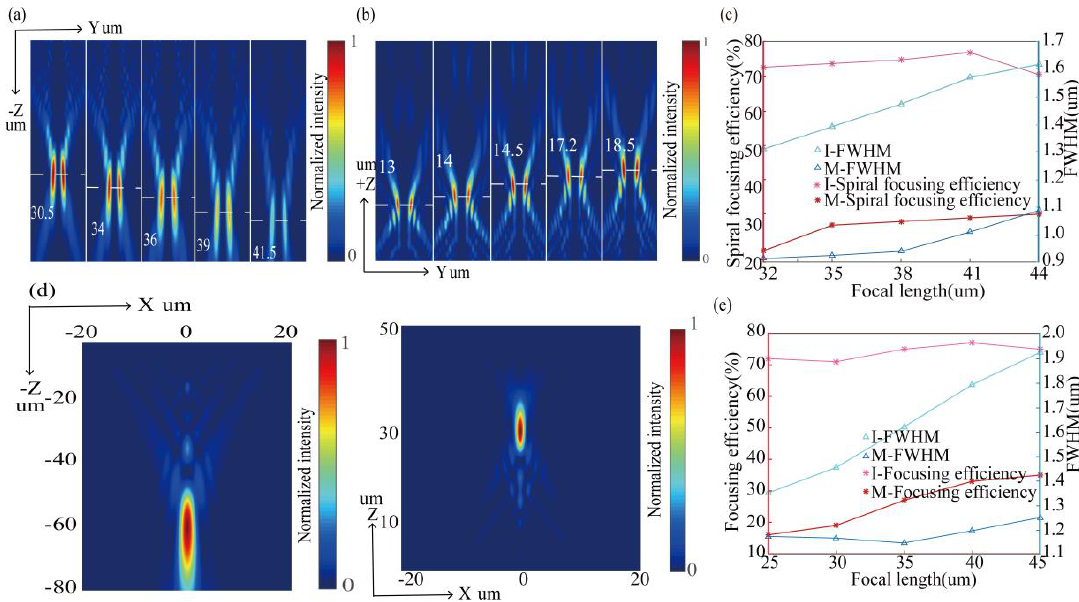
Figure 6. ( a , b ) Simulated intensity profiles on the y–z cross section of transmitted light and reflected light are produced by MSF generators with different focal lengths, respectively. ( c ) Simulated values of full width at half maximum (FWHM) and spiral focusing efficiency for several MSF generators with different focal lengths in two modes. ( d ) Simulated intensity profiles on thee y–z cross section for the MF generator in transmission mode and in reflection mode. ( e ) Simulated values of FWHM and focusing efficiency for several MF generators with different focal lengths in two modes.